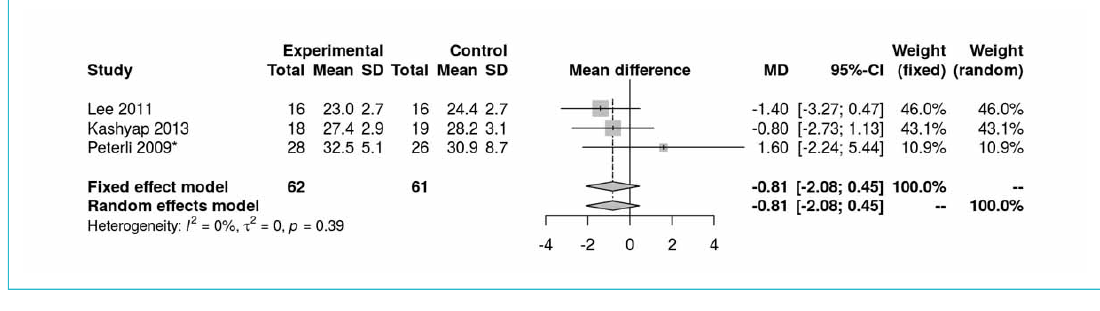
Figure 6e: Body mass index (BMI) at 24 months.